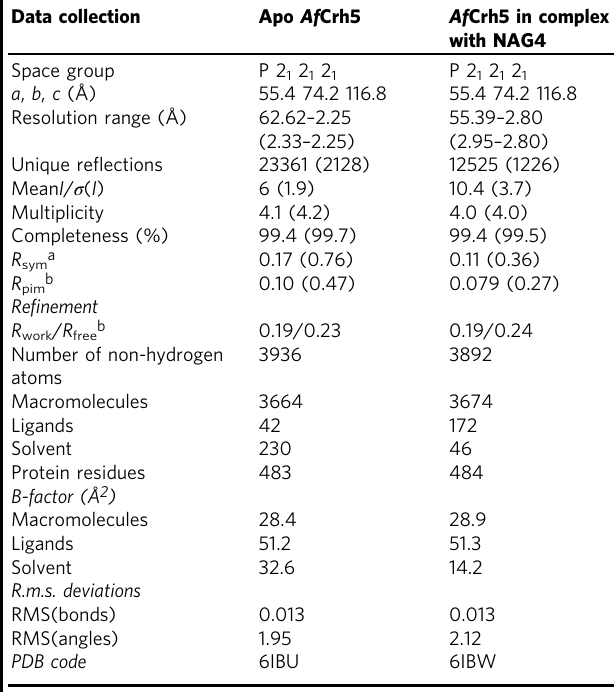
Table 2 Summary of data collection and structure re fi